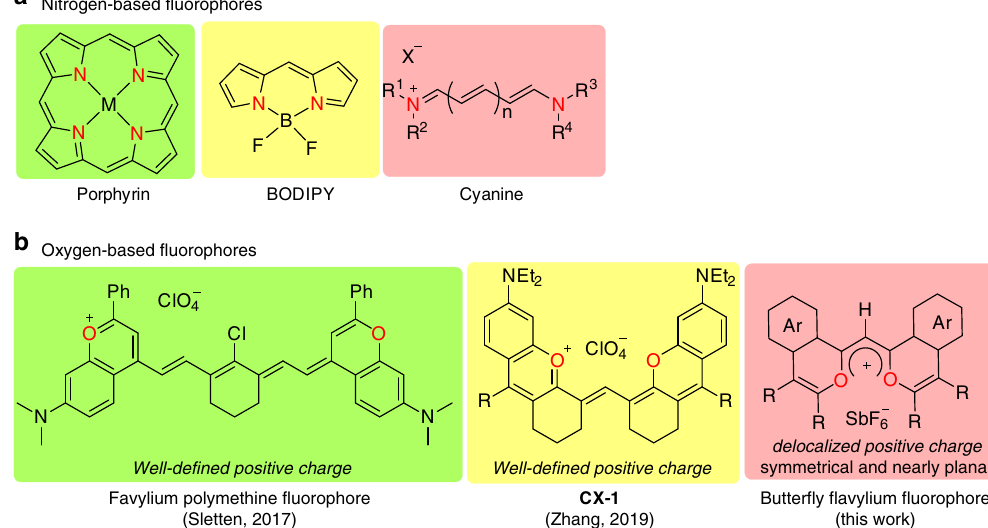
Fig. 1 Representative organic fl uorophores. a Nitrogen-based fl uorophores. b Oxygen-based fl